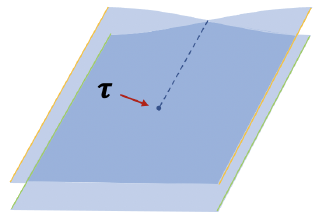
Figure 7. Closed string joining/splitting is implemented by a Z 2 twist operator τ in the symmetric product CFT. The orange (respectively green) edges are